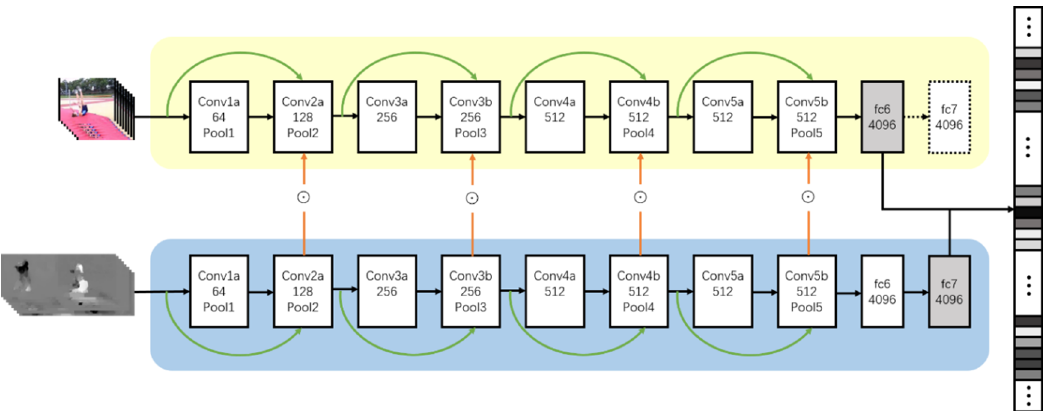
Figure 6. The structure of the encoder. Each stream is constructed on the proposed Res-C3D, as depicted within the area of yellow and blue rounded rectangles. The orange arrows show the residual connections from the motion stream to the appearance stream, and ⊙ indicates the element-wise multiplicative operation. The final feature vector is the combination of outputs of fc6 in the appearance stream and fc7 in the motion stream.